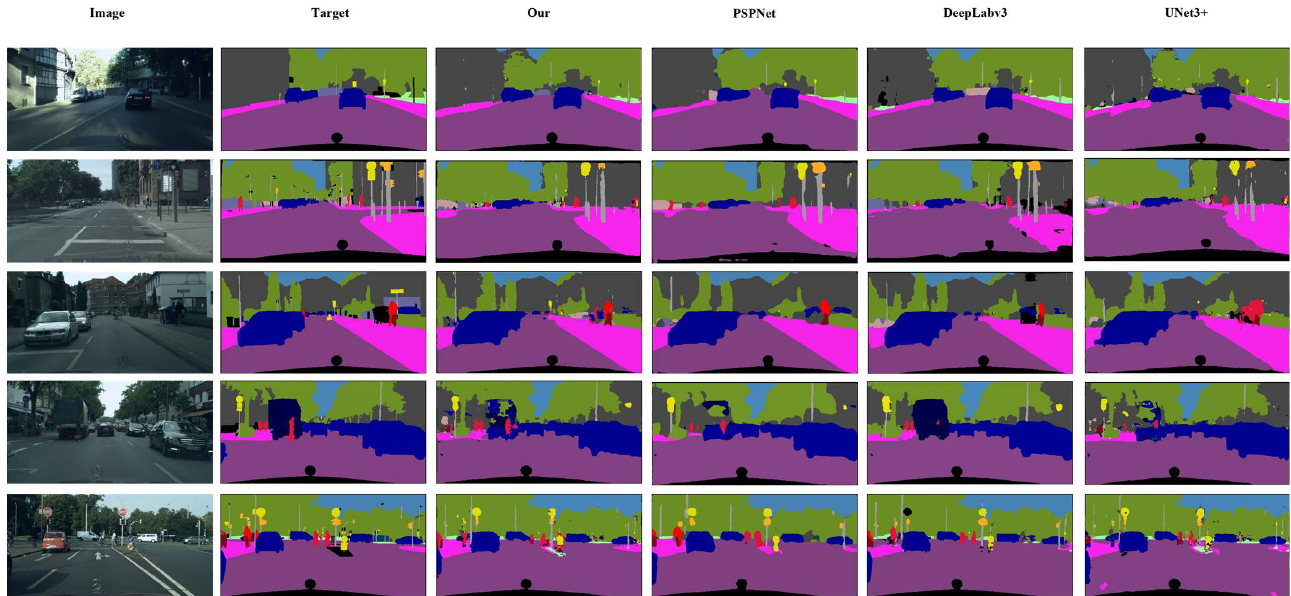
Figure 19. Visualization results on Cityscapes (including complex class). Table 8. Performance comparison of each model on the Foggy Cityscape dataset.